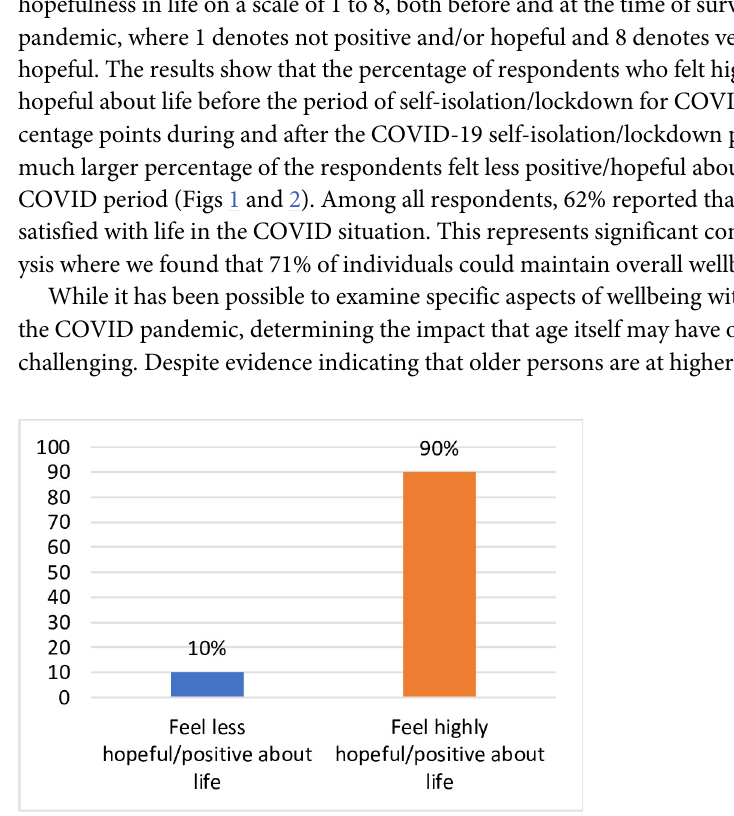
Fig 1. Percent of respondents feeling positive/hopeful pre-COVID-19. South Australia 2020. Source: Figures generated by the authors from results of Impact of COVID-19 on the wellbeing of individuals in South Australia 2020